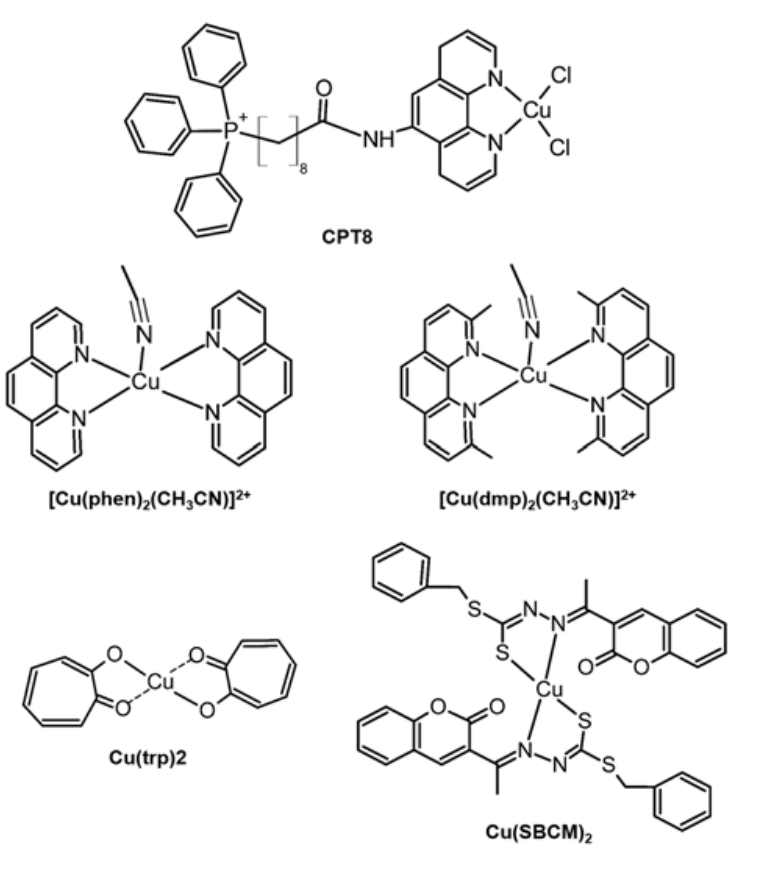
Figure 9. Cu complexes regulating the activity and expression of MMPs.